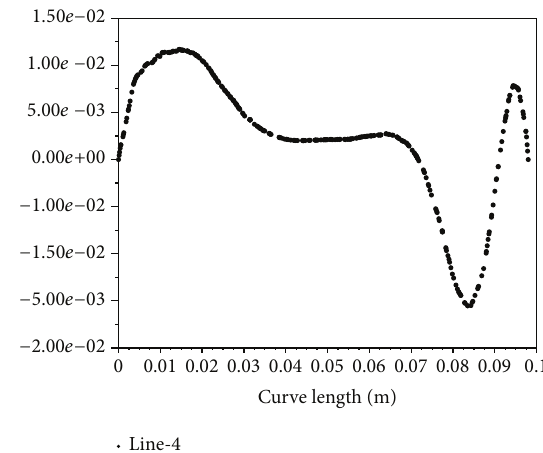
along AB; on the axis of pipe there is tiny flow to the 𝑌 axis, but apparent flow to the 𝑌 axis exists near the ends of